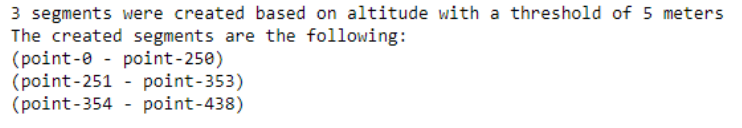
Figure 12. Detected stops of evaluated trajectories.